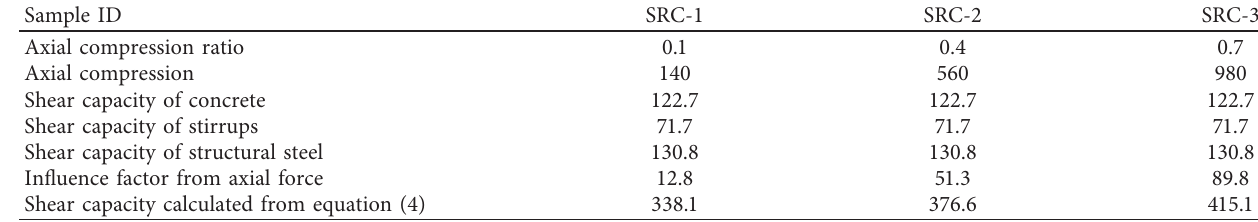
Table 8: Shear capacity calculated by equation (4).